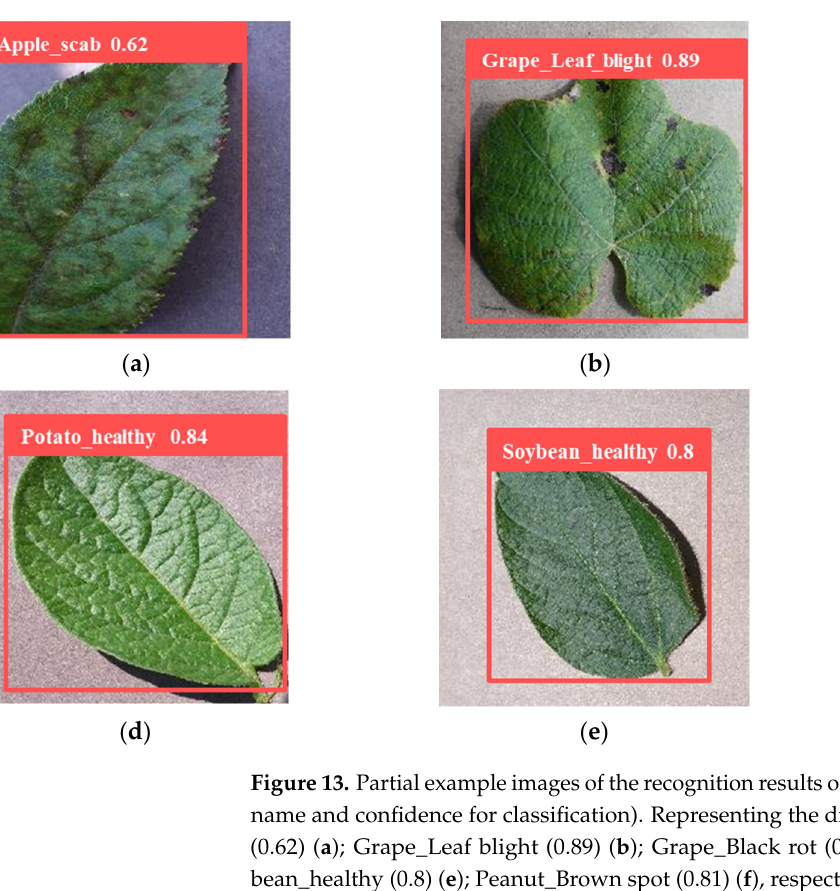
Table 5. Comparison of recognition performance of different network models (currently mainstream single-stage and two-stage target detection models and the model proposed in this paper).